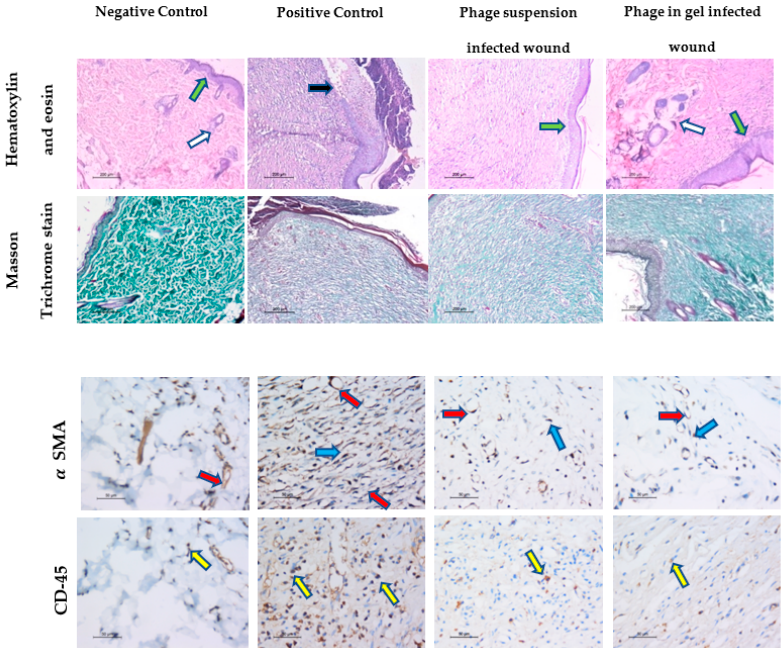
Figure 8. Histological analysis of wounded skin section from different rat groups at the 17th-day post wounding. Hematoxylin and eosin (H&E) staining, × 100, Masson Trichrome stain, × 100 and IHC by using α -SMA, and CD-45, × 400 showed in the non-infected, non-treated group complete skin wound healing and remodeling, the infected non-treated group shows epidermal ulceration and crust formation, early inflammatory phase of wound healing and a minimal amount of fibrosis, denoting delayed wound healing. While the infected groups treated with phage suspension and phage embedded in gel show, a complete wound healing and remodeling with adequate amount of fibrosis and epidermal re-epithelialization in the latter group denoting complete maturation of the healing